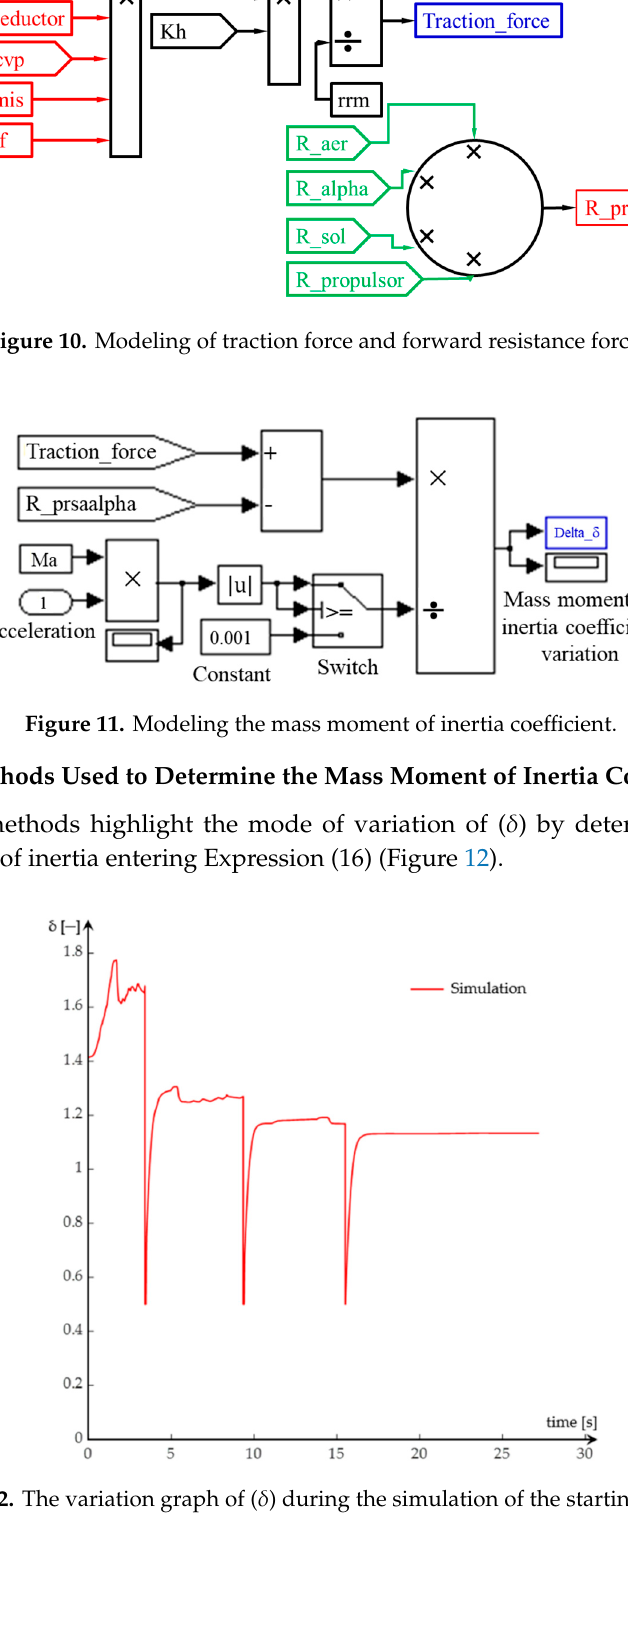
Figure 12. The variation graph of ( δ ) during the simulation of the starting process.